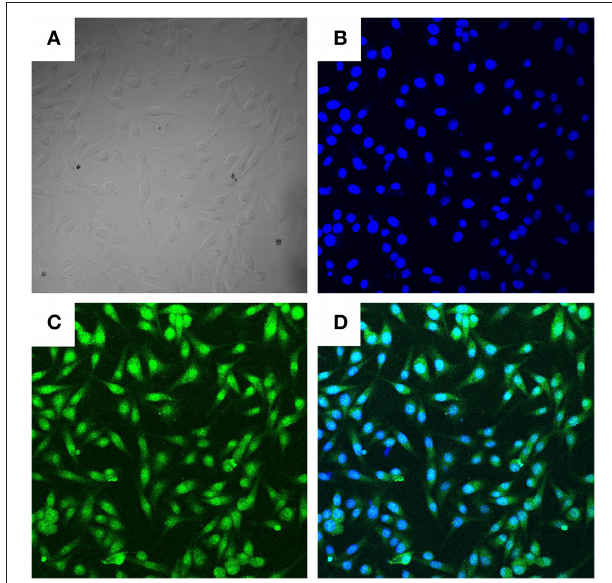
FIGURE 1 | Morphologic observation of BMECs (400 × ). Three independent experiments were carried out by fluorescence confocal analyses. (A) Light microscope observation of BMECs. (B) . DAPI staining (Blue, DNA). (C) Cytokeratin − 18 (Green). (D) Merge of (B,C)